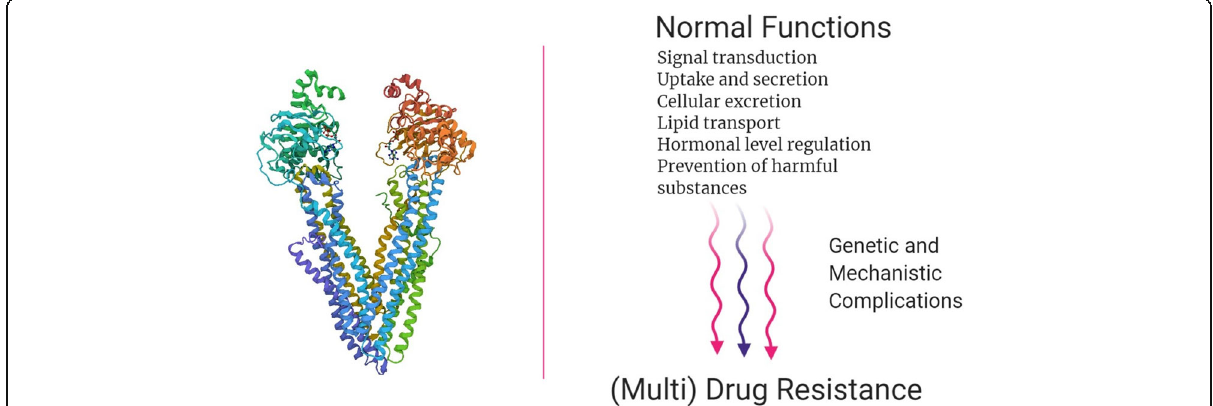
Fig. 3 ABCB1 transporter (as a representative example of ABC superfamily of transporters). Normal functions of ABC transporters. (structure from RCSB